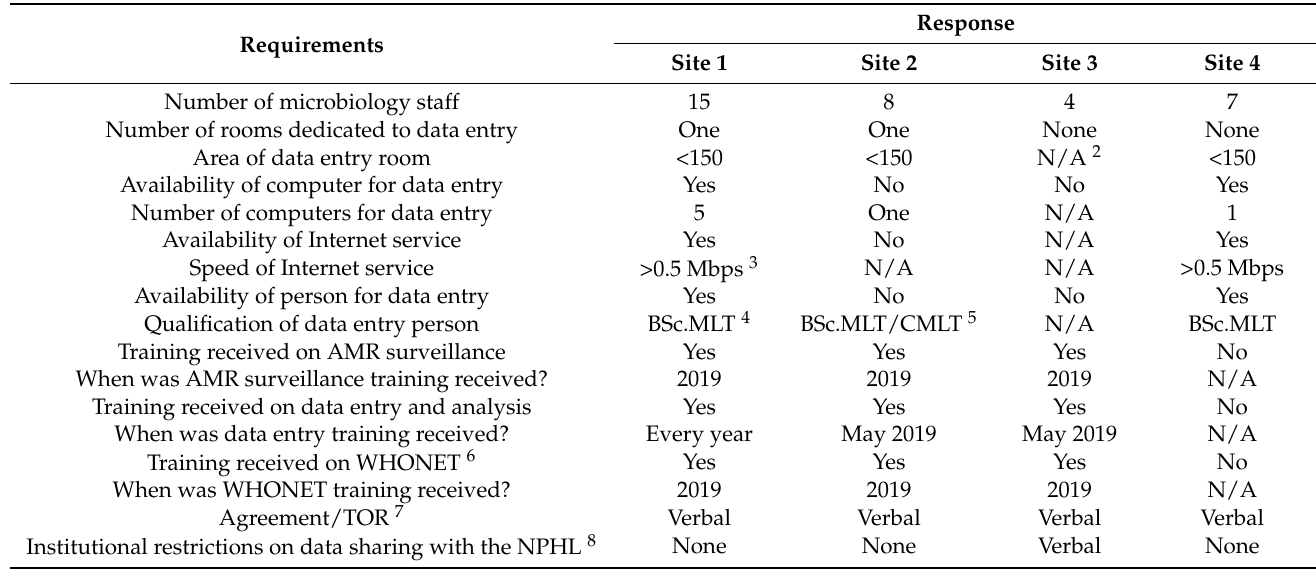
Table 5. Assessing the availability of basic infrastructure and specific requirements in four “non-reporting” AMR 1 surveillance sites in Province 3 of Nepal (January to February